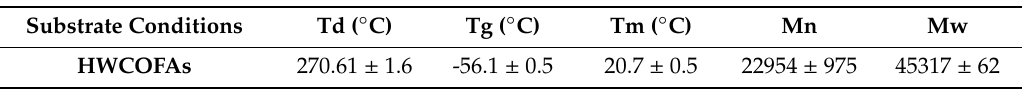
Table 2. Properties of PHA polymer extracted from P. putida KT2440 grown on hydrolysed waste cooking oil fatty acids